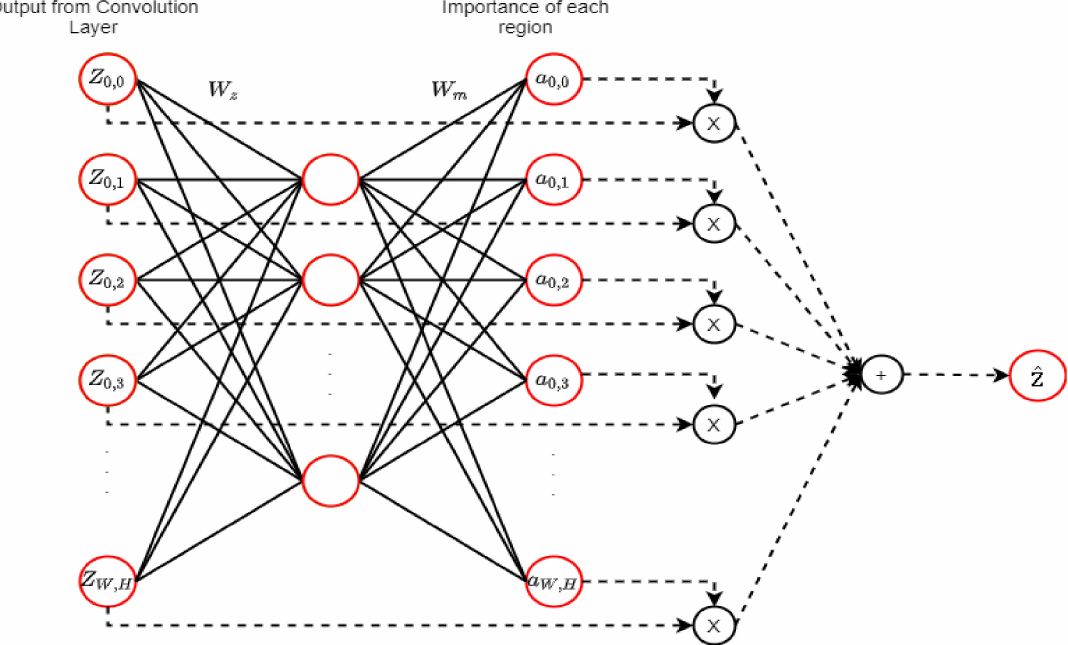
Figure 11. An attention mechanism (AM) (adopted from [51]). Z i , j denotes the output map from the middle of the convolution layer of a network. The map is propagated to the next layer of the network, and the AM calculates the weighted average of Z i , j as ˆ Z . The fully connected layer calculation is represented by the straight lines, and the weighted average calculation is represented by dashed lines. The neural network is utilized by the AM to estimate a i , j and the importance of each Z i , j